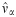
Histogram similarity for the optimal intra-subject variability.Histograms of the parameters of the psychometric functions of the behavioral data (gray fill, 33 × 5 data points) versus the simulated data (black outline, 33 × 5 simulated data points averaged over 1000 simulations) with optimal noise level at the pair ν^α, ν^β.